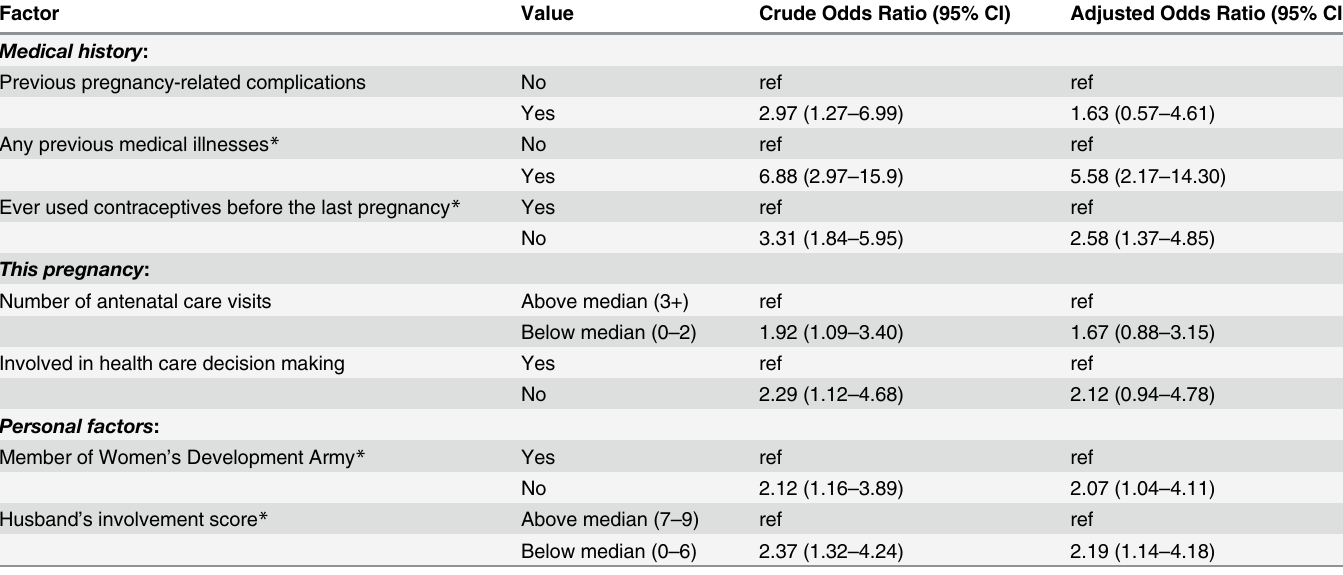
Table 4. Bivariable and multivariable analysis of factors significantly associated with maternal mortality for 62 rural Tigrean women who died of maternal causes and 248 controls (who had given birth in the study period May 2012 to August 2013 and lived in the same communities as the maternal